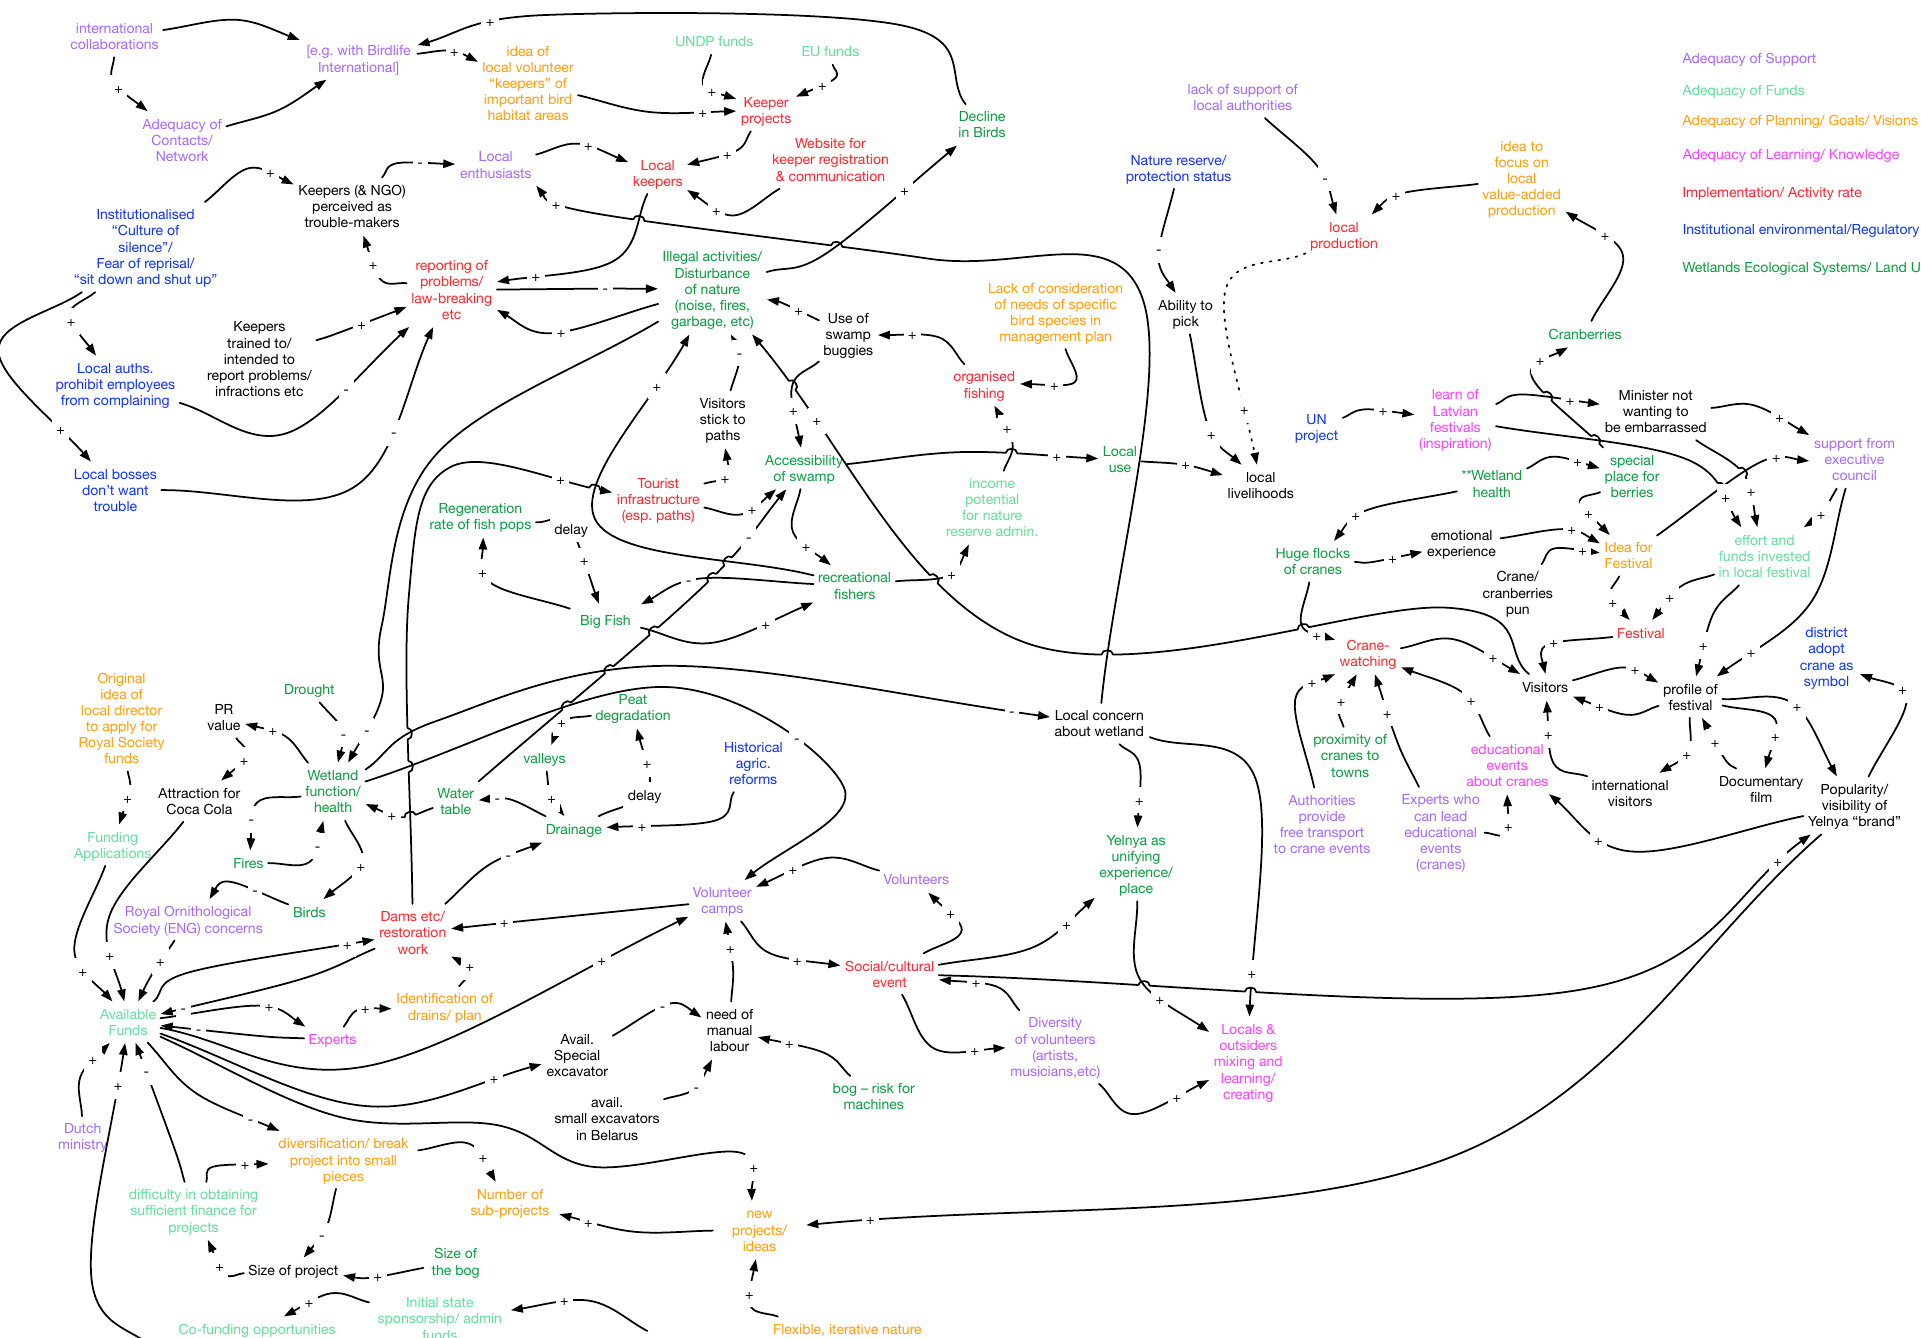
Figure A2:3. Case Bogs, Theme: Implementation, activity